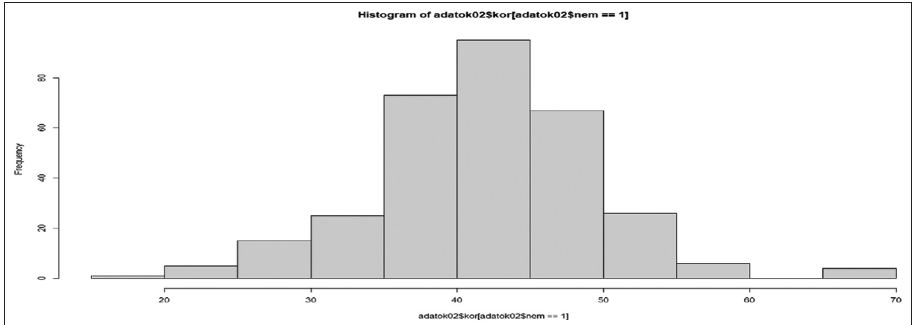
FIGURE 2. The age distribution of all men measured under the investigation (X-axis shows the age groups of 10-70 years, Y-axis shows the size of the number of